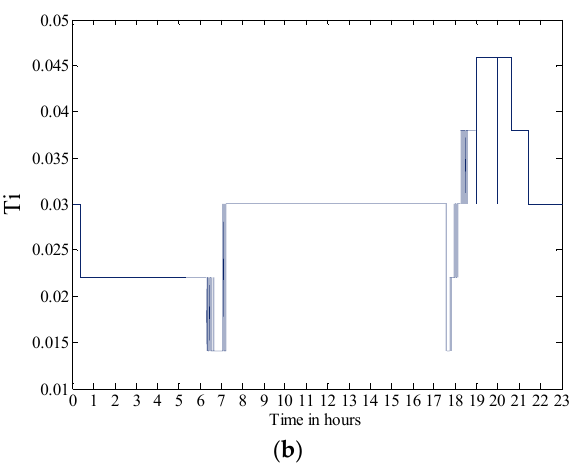
Figure 11. ( a , b ) show the variation of K p and T i respectively for different fuel cell controller set points using the fuzzy ‐ based PI controller.